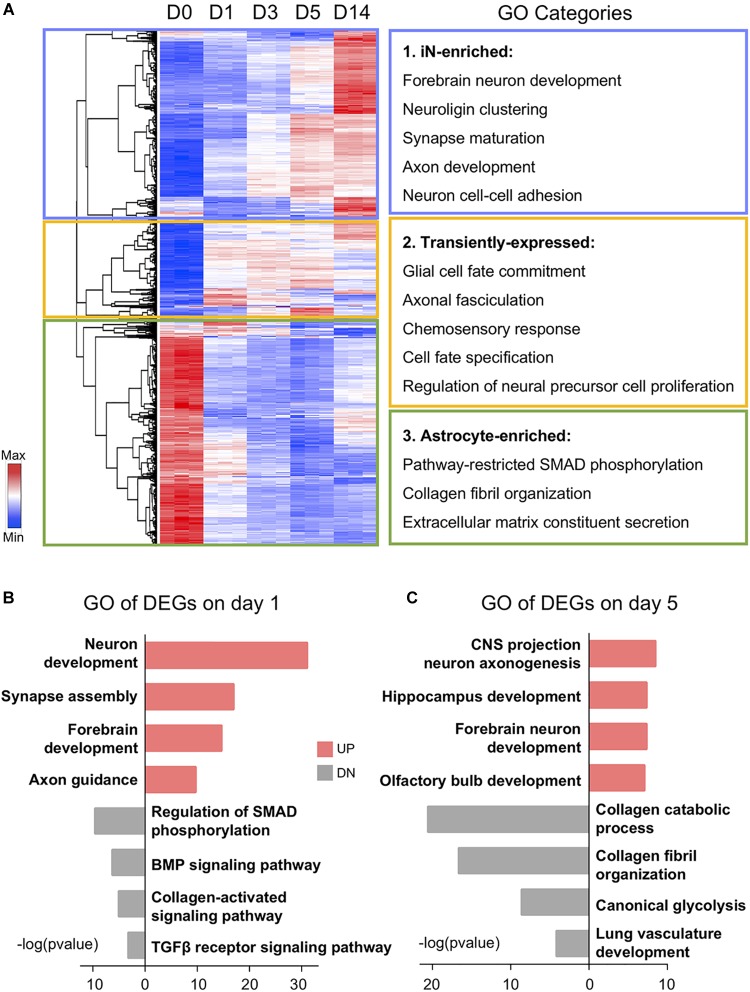
Gene ontology (GO) analysis showing functional transition from astrocytes to neurons. (A) Hierarchical clustering and heat map of RNA-seq data showing all the differentially expressed genes (1,889 DEGs) among D0–D14 samples. Red color indicates high expression level, whereas blue color indicates low expression level. DEGs were divided into three clusters based on their expression patterns. GO categories associated with each cluster are shown on the right. (B,C) Top four significant GO terms associated with upregulated (UP) and downregulated (DN) genes on days 1 and 5 of small molecule treatment. Note that upregulated GO terms are associated with neuronal genes and downregulated GO terms are associated with glial genes.